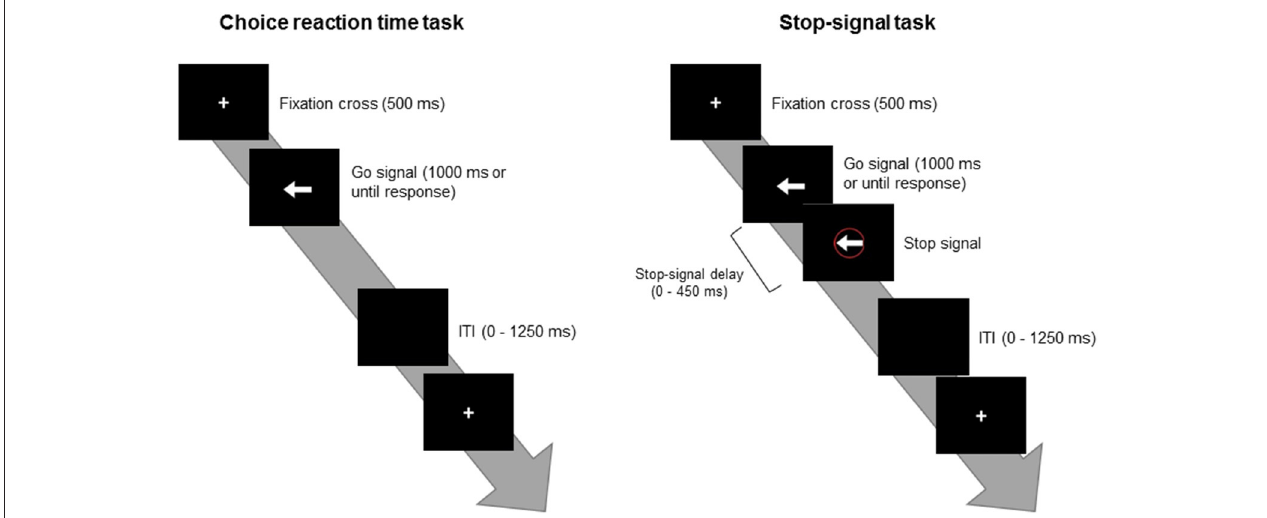
FIGURE 1 | Depictions of the choice reaction time task ( left ) and the stop-signal task ( right ). ITI , inter-trial interval.